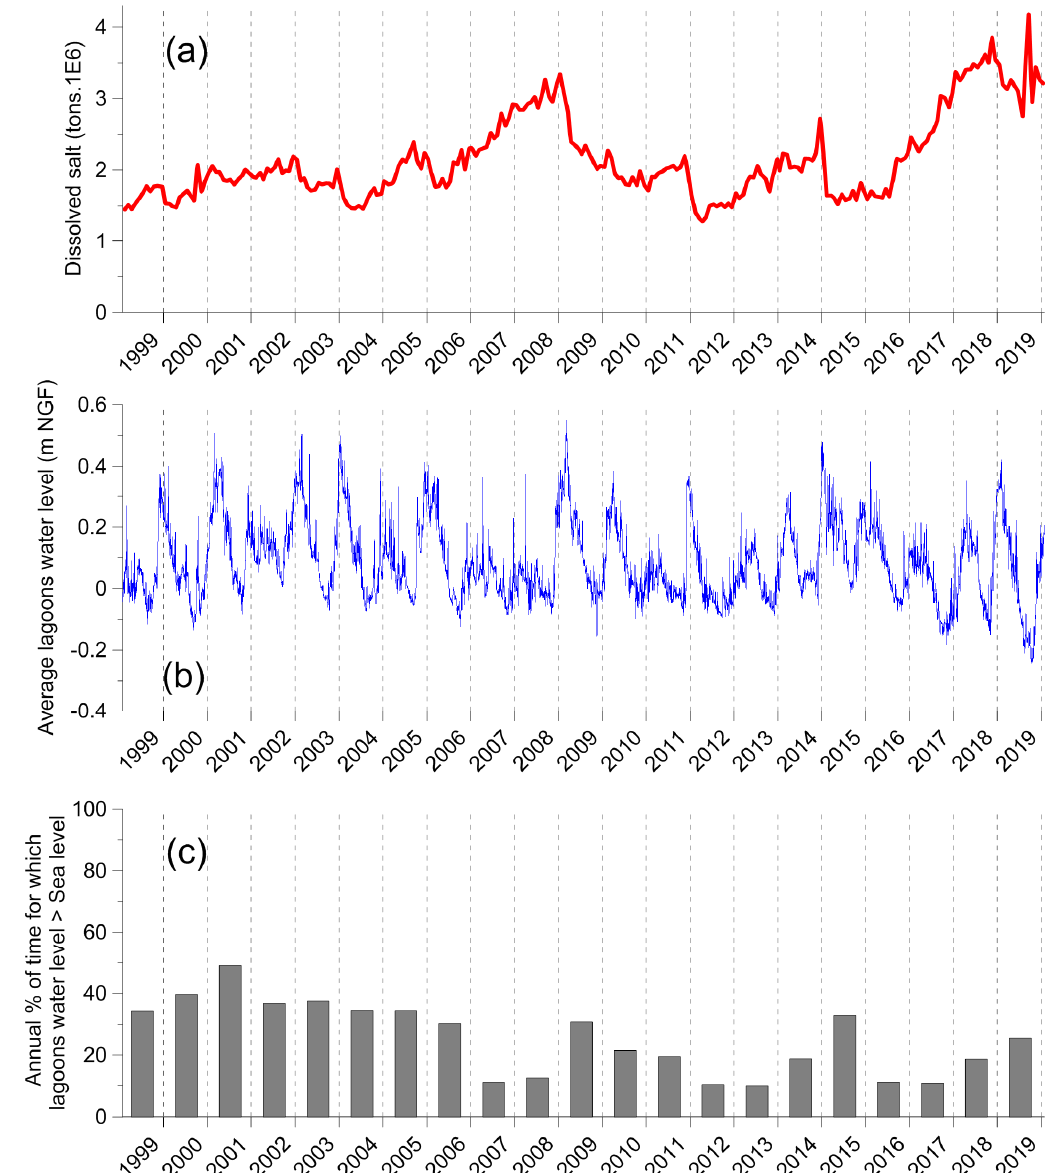
Figure 11. ( a ) Total dissolved salt mass in the Vaccarès Lagoon System from 1999 to 2019, calculated as described in part 2.2.2. ( b ) Mean water level in the Vaccarès Lagoon System, which is the average value of the water levels measured at locations 12, 14, and 15 (see Figure 2). ( c ) Annual percentage of time with water level in the Vaccarès Lagoon System exceeding sea level (measured at location 13).